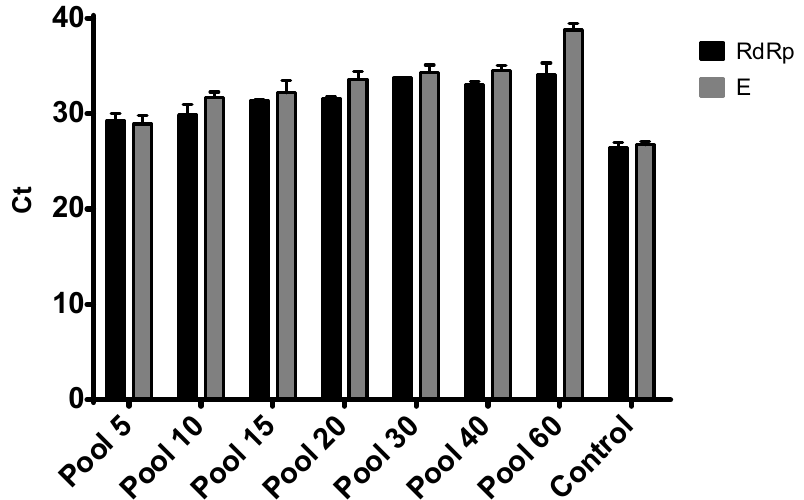
Figure 1. PCR results for the pools of 5, 10, 15, 20, 30, 40 and 60 samples using the Kogene kit for RdRp and E genes. Results are presented as average C t ± SD from two independent experiments. Positive control is represented by the sample used for pooling.